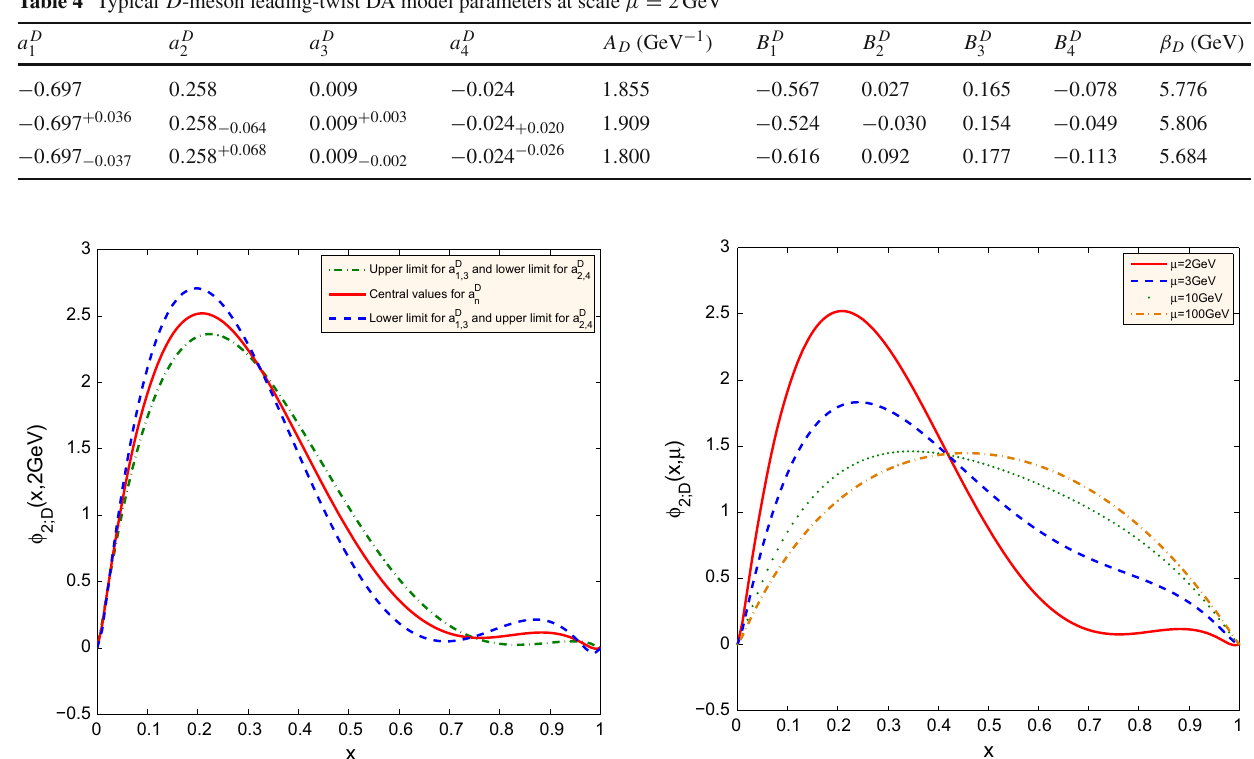
x ∼ 0 . 2, which is consistent with the LM model, but is incon- sistent with the KLS, the LLZ, and the GH model which have peaks at a larger x ( ∼ 0 . 3 − 0 .